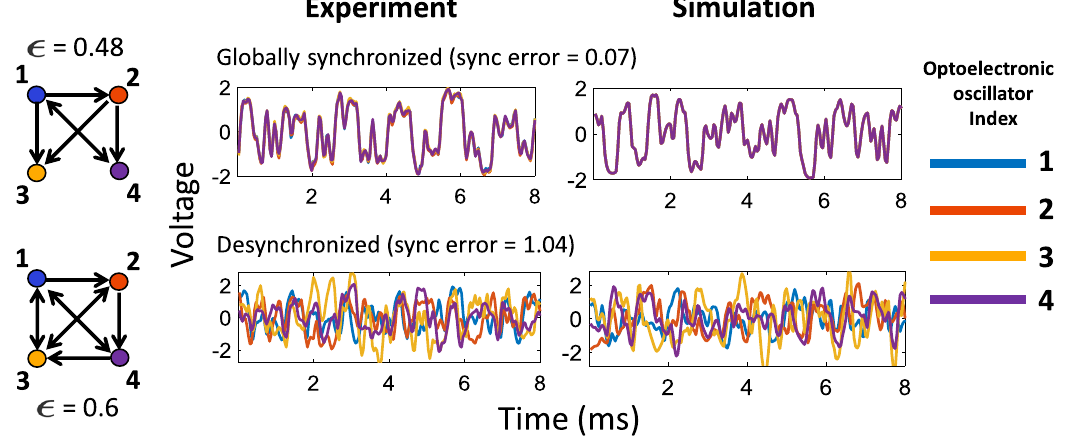
FIG. 3. Examples of experimental and simulated time series from two optoelectronic oscillator networks showing globally synchronous (upper) and completely desynchronized (lower) behavior, respectively. For the simulations, we use the noise strength κ ¼ 10 − 6 . In the plots, purple overlays orange, which overlays red, which overlays blue.